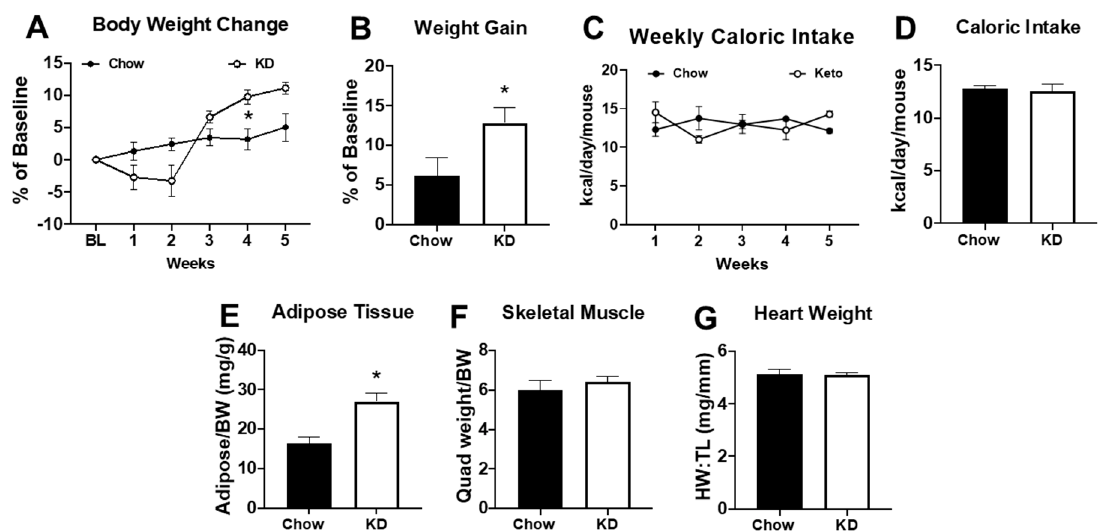
Figure 3. Five weeks of a ketogenic diet increased body weight and adiposity. ( A ) Body weight change relative to baseline, ( B ) percentage of weight gain relative to baseline, ( C ) weekly caloric intake, and ( D ) average caloric intake over 5 weeks in chow-fed ( n = 6) and ketogenic diet (KD, n = 9) mice; ( E ) adipose tissue weight (from the inguinal fat pad) normalized to body weight (BW), ( F ) skeletal muscle weight (from the quadriceps) normalized to body weight (BW), and ( G ) heart weight normalized to tibia length (HW:TL) in chow ( n = 6) or ketogenic diet ( n = 9). * p < 0.05 vs. chow.